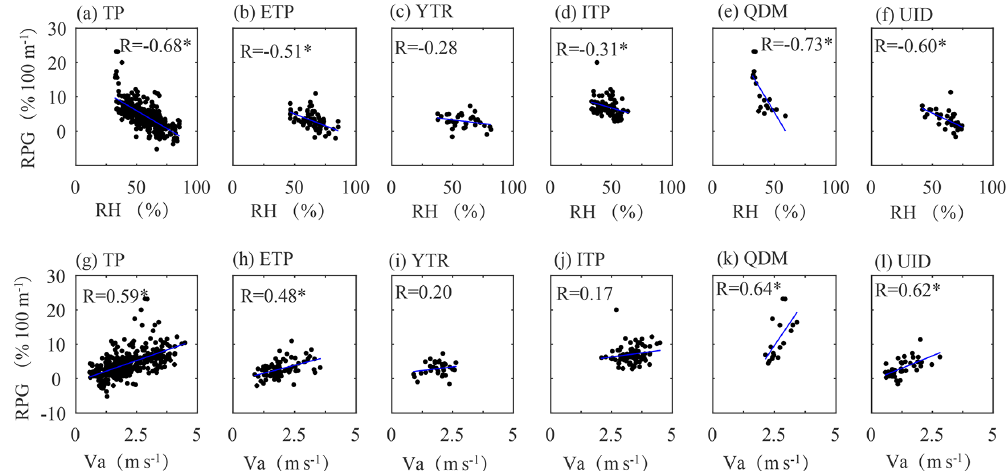
Figure 8. Relationships between annual RPGs and (a–f) basin-average relative humidity (RH) and (g–l) wind speed (Va) in different sub- regions of the TP. ETP: eastern TP; YTR: Yarlung Tsangpo River basin; ITP: inner TP; QDM: Qaidam basin; UID: upper Indus.